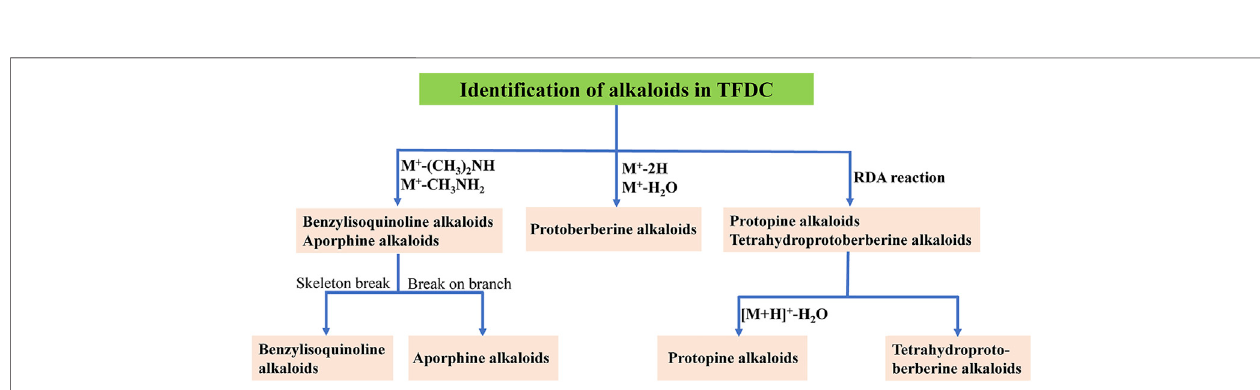
FIGURE 3 | Flowchart for the identi fi cation of the structure type of alkaloids in Tongfengding capsule (TFDC).